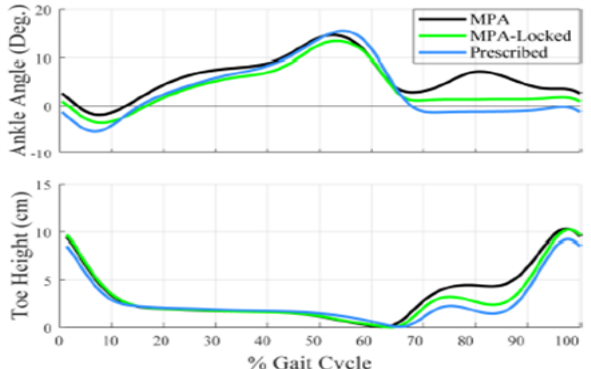
Figure 4. MTC with MPA(Proprio), MPA-Locked and conventional ESAR in level ground.